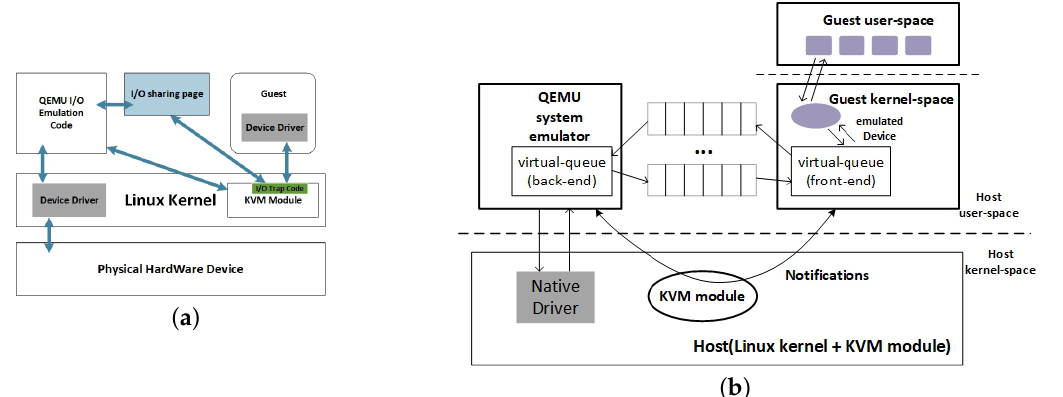
Figure 1. ( a ) I/O virtualization model in QEMU. ( b ) I/O virtualization model in